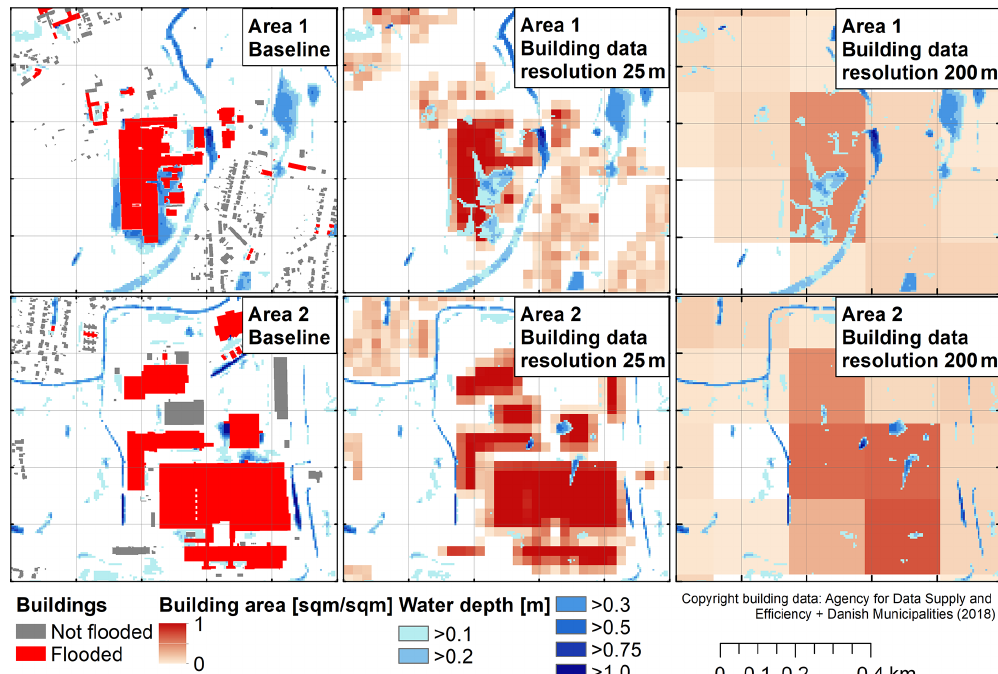
Figure 2. Building footprint polygons and total building footprint areas aggregated to data resolutions of 25 and 200m, shown for two selected areas in the case study together with flood maps simulated based on the building dataset shown in each subfigure for a return period of T = 100 years. In the baseline flood simulation, buildings were included as obstacles in the terrain model, while this was not the case in the flood simulations performed for the aggregated building datasets. Vector building data in the left column are subject to copyright conditions defined in © Agency for Data Supply and Efficiency and Danish Municipalities